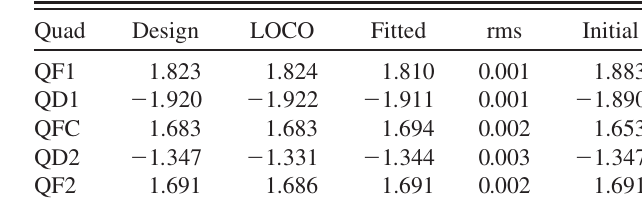
TABLE I. Quadrupole parameters.